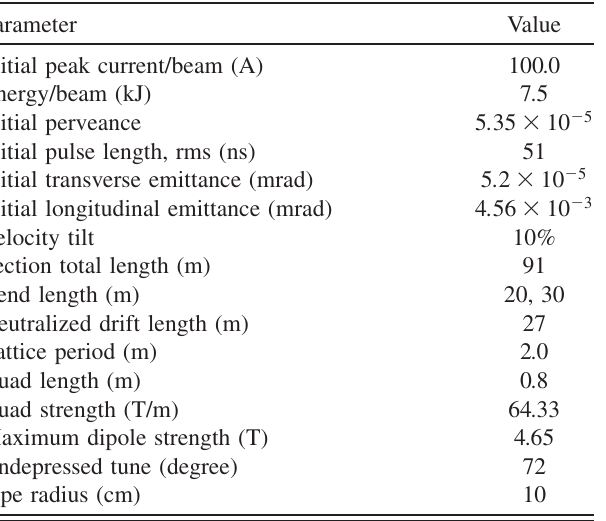
TABLE I. Parameters used in this study.